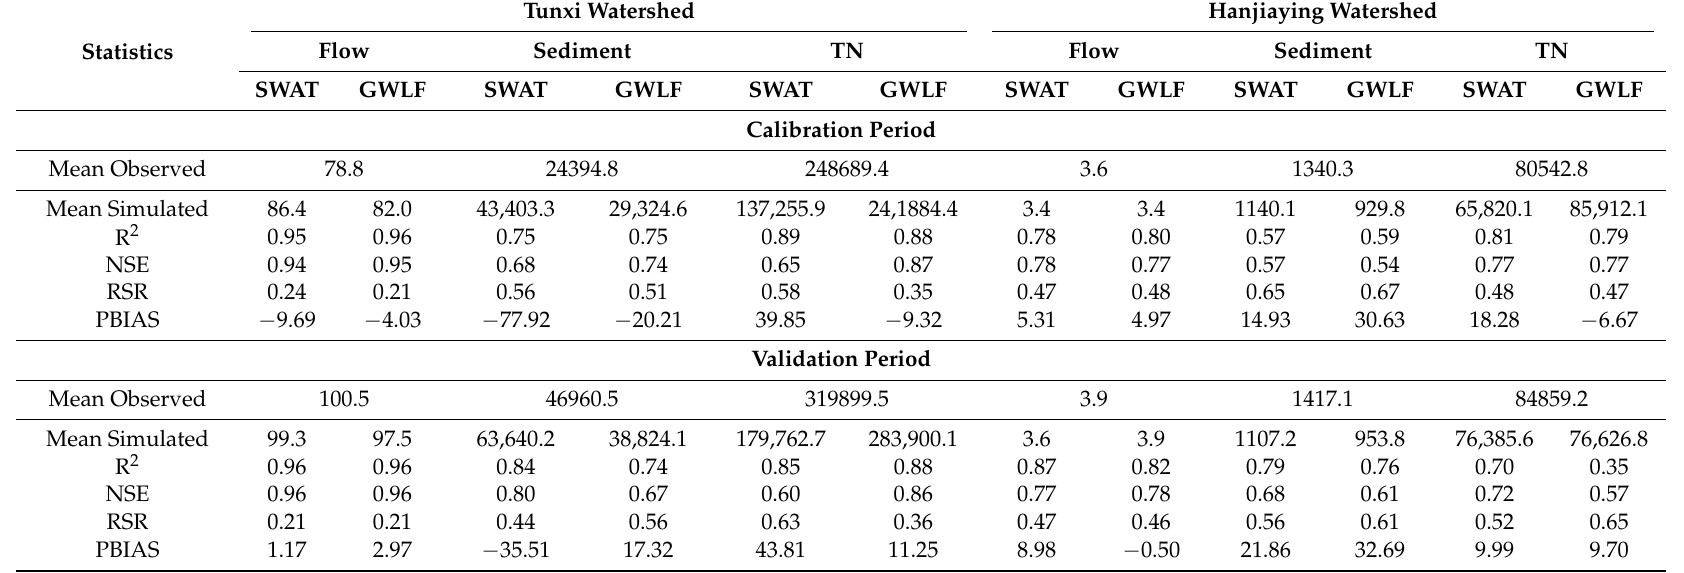
Table 6. Statistics values of model